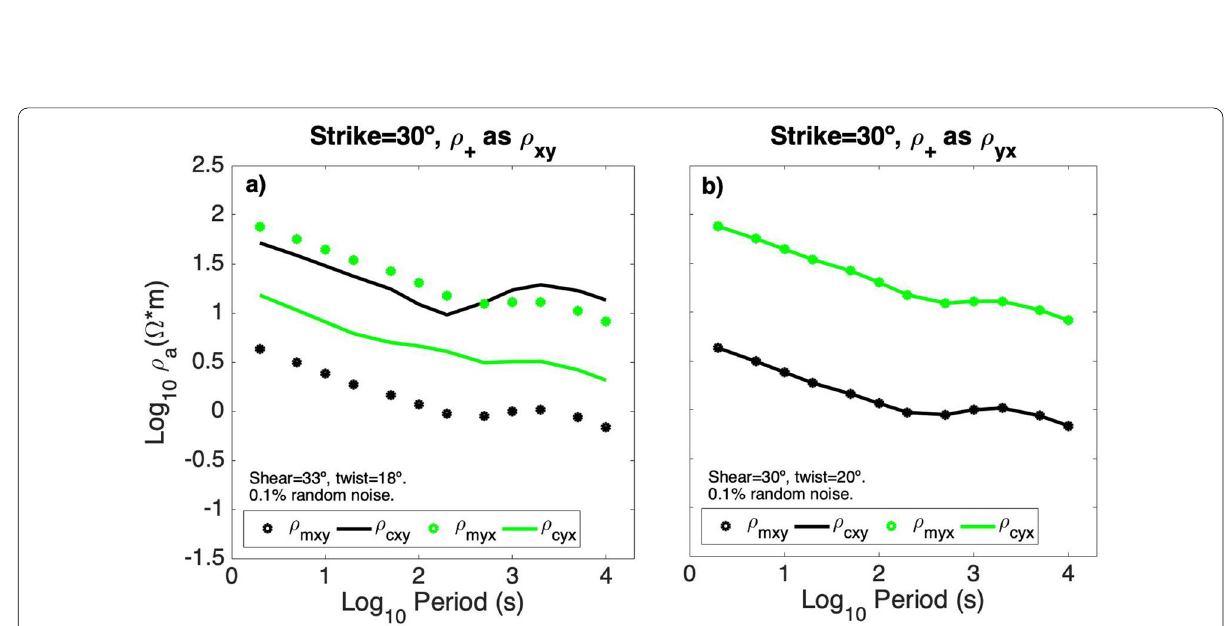
Fig. 4 Explicit comparison of the measured and computed values for a strike of 30°. a Assuming that ρ present only the corresponding components xy and yx . It can be observed that the computed resistivities in b fall in the correct sense. This means that we must identify a strike of 30° with ρ